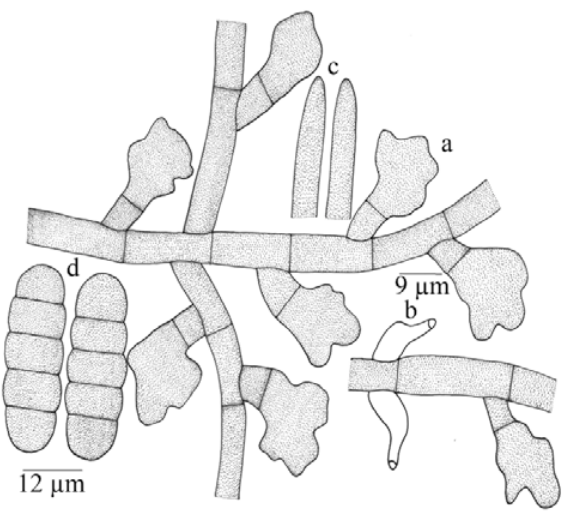
Figure 128. Meliola ziziphi a - Appressorium; b - Phialide; c - Apical portion of mycelial setae; d -